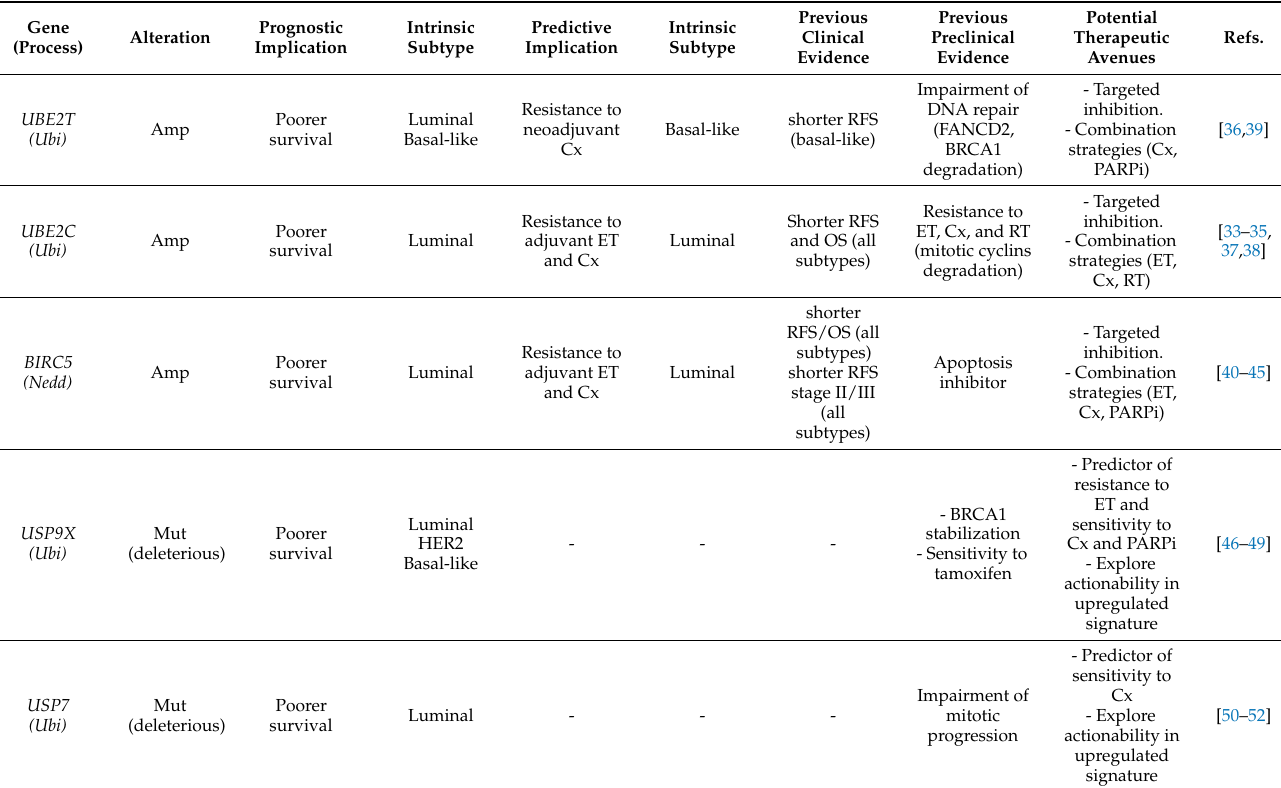
Table 1. Summary of genomic vulnerabilities of the SUN machinery with prognostic and predictive implications and potential therapeutic